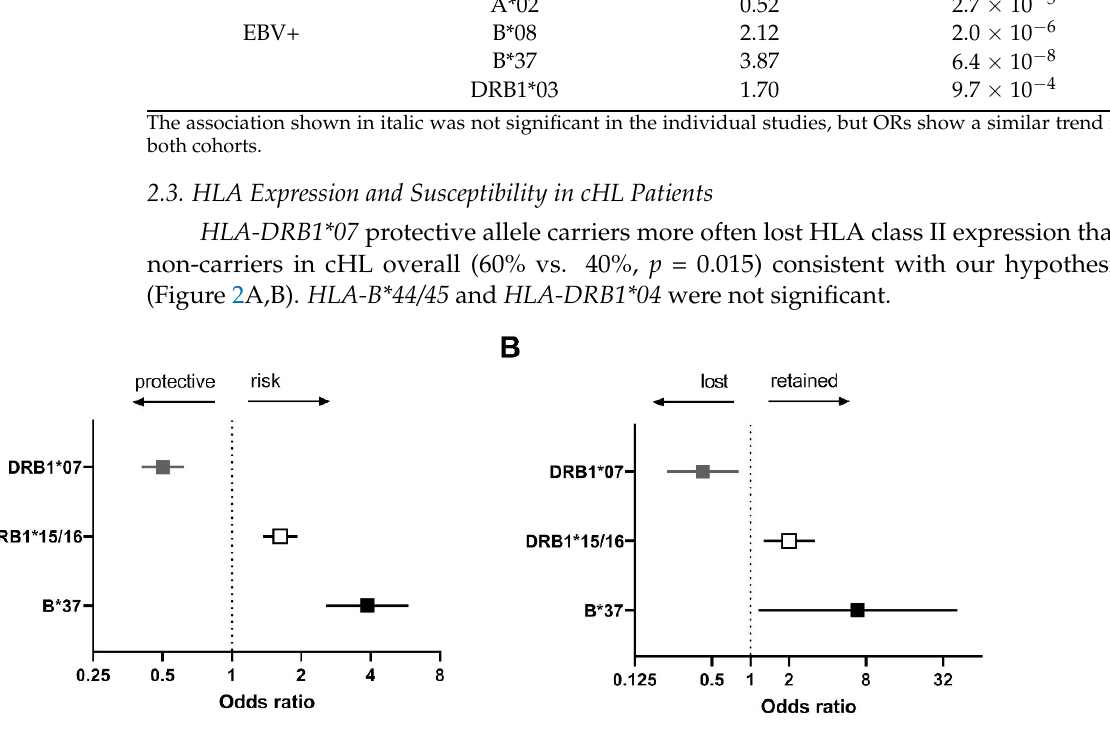
Figure 2. Association between cHL-associated HLA alleles and HLA expression. The odds ratios (squares) and 95% confidence intervals (whiskers) of cHL-associated HLA alleles ( A ) and loss or retention of HLA expression ( B ) in cHL overall (grey), EBV − cHL (white), and EBV+ cHL (black). The black arrows above the forest plot indicate protective or risk effects of cHL ( A ) and loss or retention of expression of the corresponding HLA class ( B ).